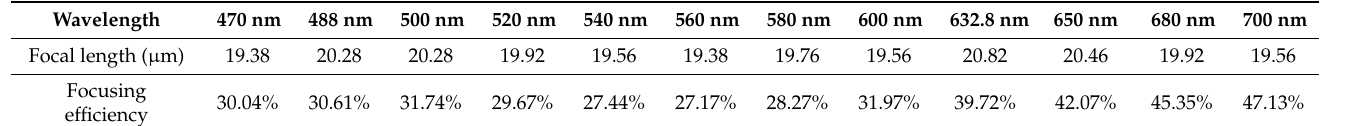
Table 1. Focal length and focusing efficiency at different wavelengths of the metalens.